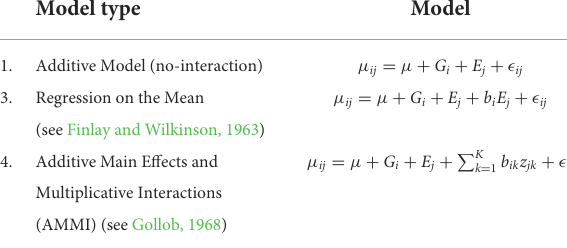
TABLE 2 Benchmark models for genotype-by-environment interaction (GEI) using a two-way table of phenotype means